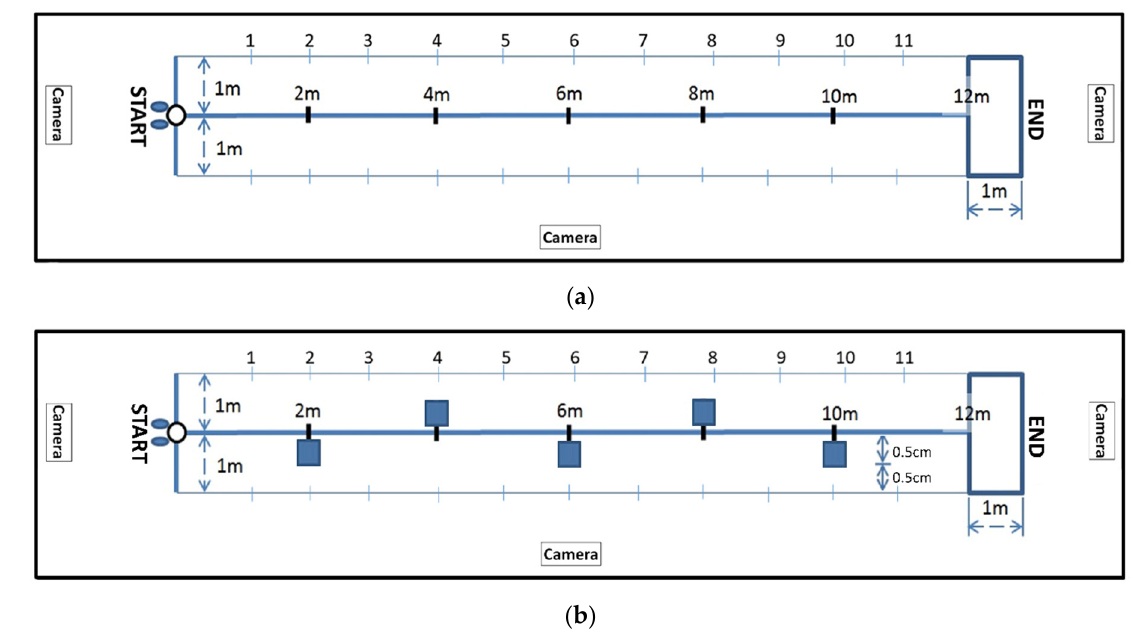
Figure 4. ( a )The test site for straight-line dribbling and the location of video cameras; ( b )The test site for zigzag dribbling and the location of video cameras.